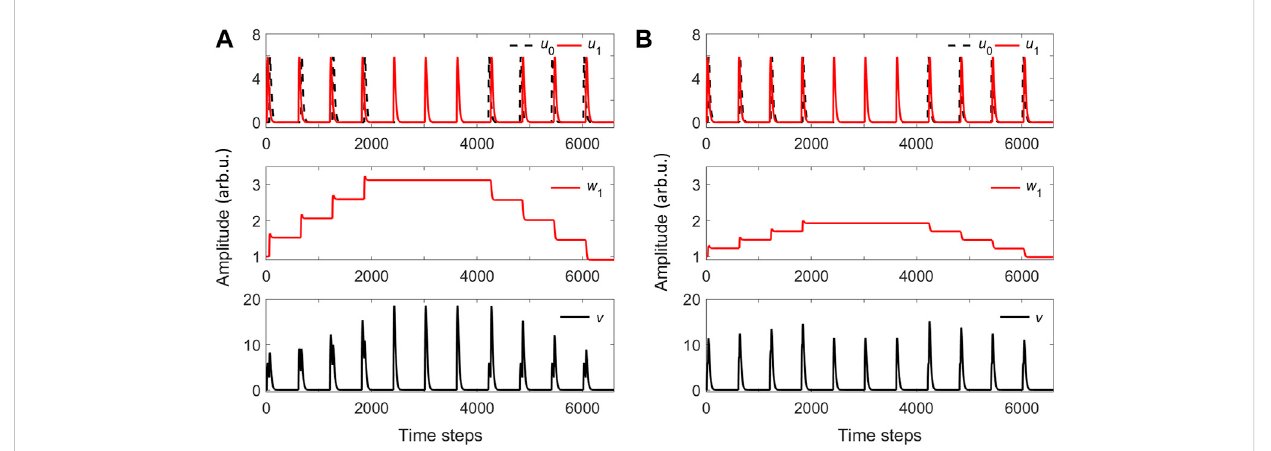
FIGURE 5 (A) Toppanel: A sequenceof twoactivation inputs u 0 and u 1 , with u 0 obeying different conditions: itappearsafter u 1 with T =55 time steps, itiszero, or it appears before u 1 with T = − 55 time steps. Middle panel: The plastic weight w 1 . Bottom panel: The ICO learning output v . The learning rate is η =0.05 and w 0 =1. (B) Same as A, but with a reduced temporal separation between u 1 and u 0 ( T =20 or T = − 20 time steps) and smaller learning rate η